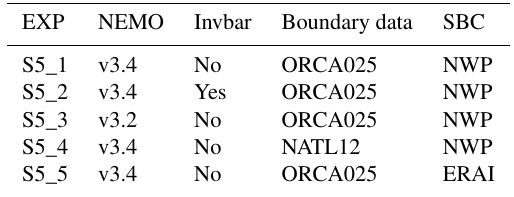
Table 3. The 5-year sensitivity experiments.